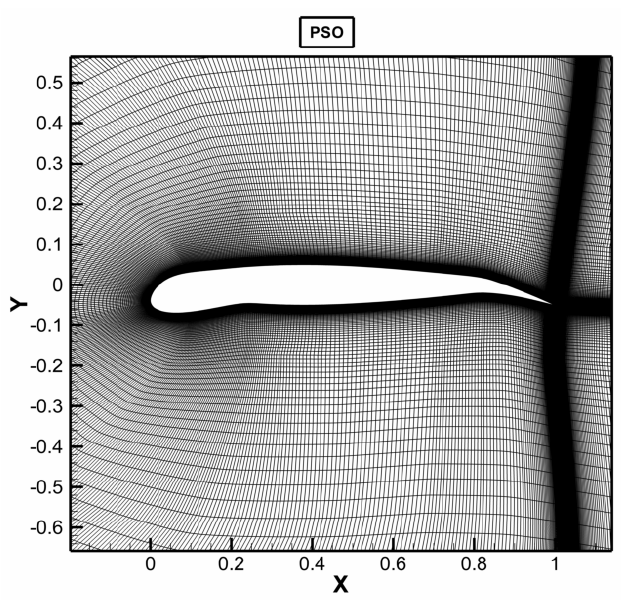
Figure 13. Computational grid (C type) for PSO airfoil, constructed using ICEM, ANSYS (2020).